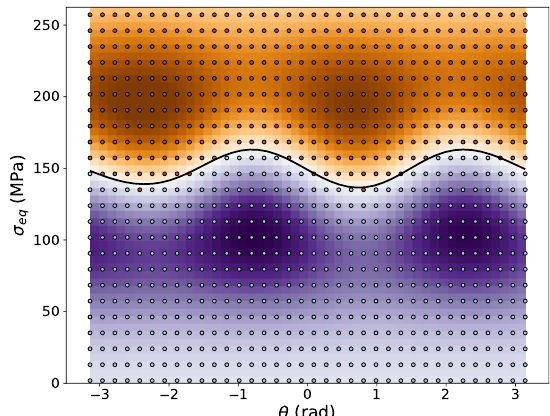
Figure 3. Field plot of the trained SVM decision function defined in Equation (18), where areas in purple color shades represent negative values and brown shades represent positive values. The numerical value of the decision function is not relevant because only its sign is taken into account in the flow rule. The isoline for f SVC = 0 is represented as a black line. Training data are plotted in light blue color for data with negative values (elastic) and in brown color for positive values